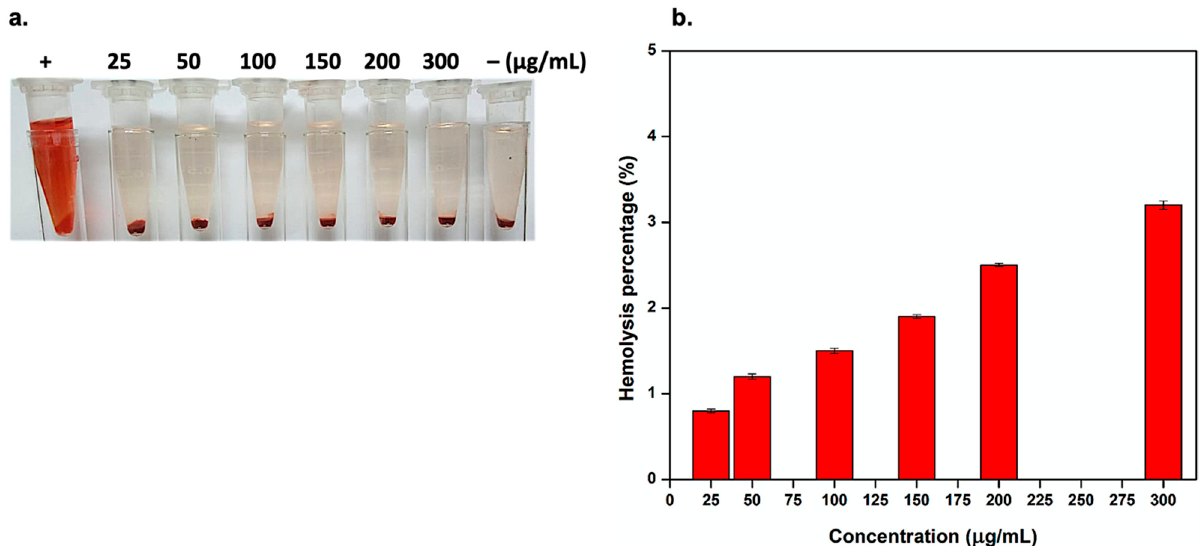
Figure 9. Hemolytic activity of LNZ–BCDs nano-bioconjugate. ( a ) Hemolytic images after treatment with LNZ–BCDs nano-bioconjugate of different concentrations (25–300 μ g/mL). Particularly, (–) and (+) signs correspond to the negative and positive controls, respectively, and ( b ) hemolysis percentage induced by the LNZ–BCDs nano-bioconjugate.